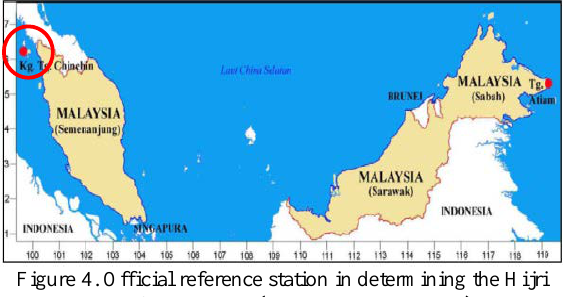
Figure 4. Official reference station in determining the Hijri date for Malaysia (Source: JAKIM,